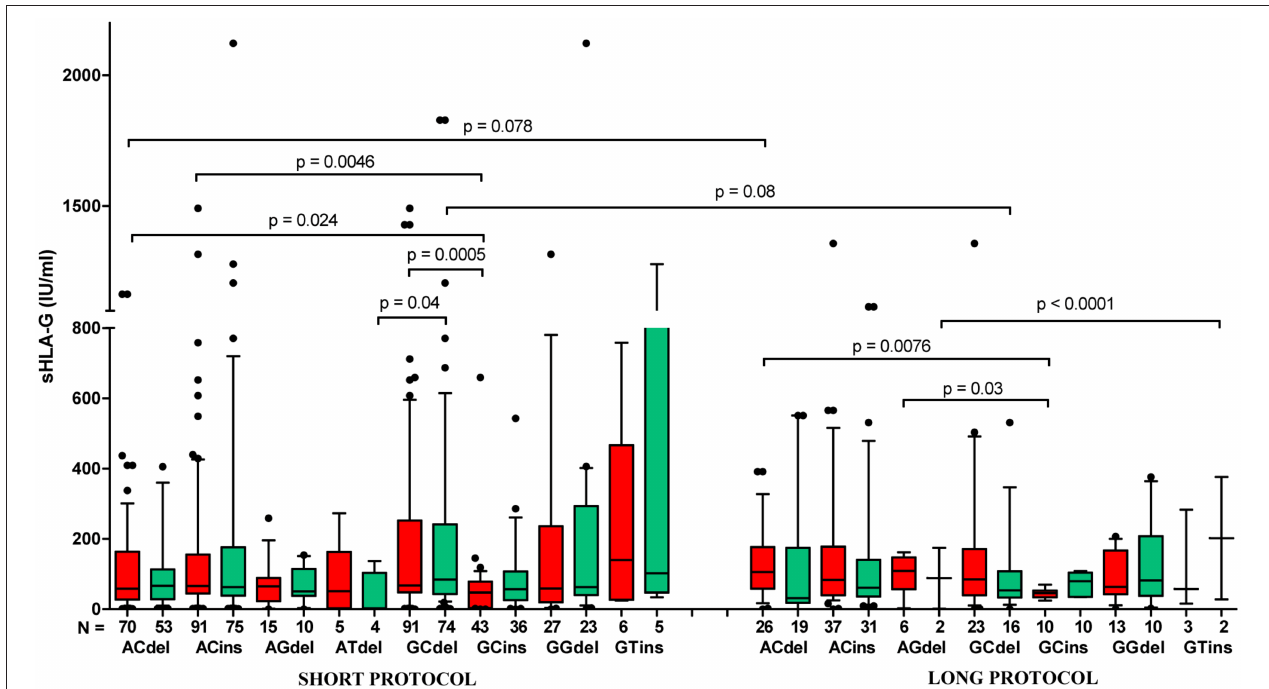
FIGURE 8 | Concentration of soluble HLA-G per milliliter of plasma (IU/ml) in all patients according to their HLA-G haplotypes, dependent on short (with GnRH antagonist) or long (with GnRH agonist) ovarian stimulation protocol. Haplotypes were estimated in the following order: rs1632947: − 964G > A; rs1233334: − 725G > C/T; rs371194629:insATTTGTTCATGCCT/del. Boxes are drawn from the first quartile (25th percentile) to the third quartile (75th percentile). Black lines in boxes are medians. Whiskers represent 10–90 percentiles. N is the number of patients. sHLA-G was measured in plasma of patients before (red boxes) and after embryo transfer (green boxes). p -values are calculated by Mann–Whitney test. Comparison of haplotypes G C del and G C ins (short vs. long protocol) by Kruskal–Wallis test, p =